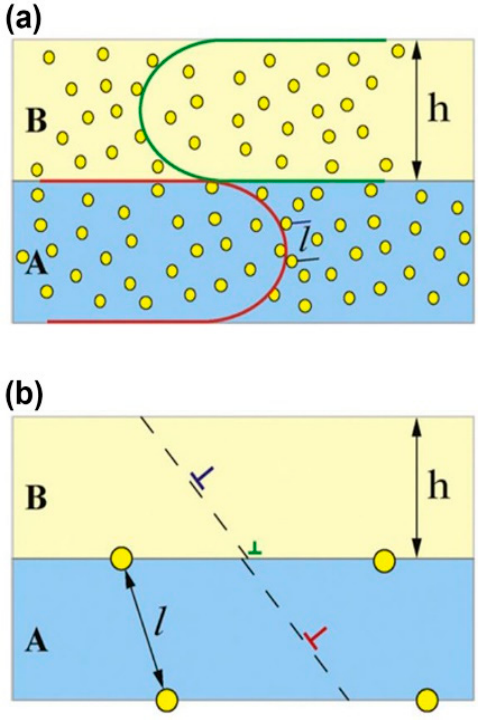
Figure 19. Schematic illustration of the bubble distribution in multilayers (the circles indicate bubbles). ( a ) When the layer thickness is a few tens of nanometers, h > l and the deformation is via confined layer slip. ( b ) When the layer thickness is of the order of a few nanometers, h < l , the yield strength is determined by the crossing of single dislocations across interfaces [43].